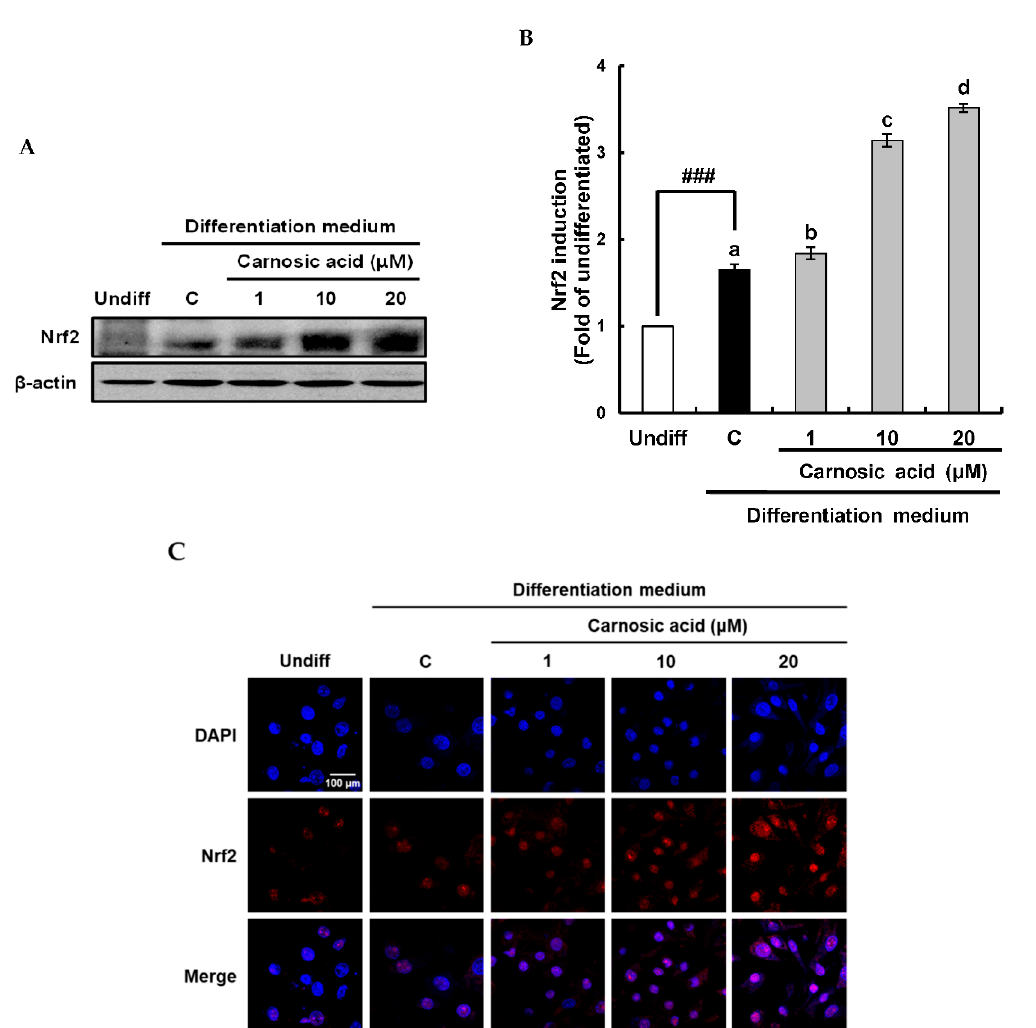
Figure 6. Effects of carnosic acid on translation and nuclear translocation of Nrf2 during MDI-induced differentiation of 3T3-L1 pre-adipocytes to adipocytes for two days. ( A ) Translation of Nrf2 by Western blotting analysis after differentiation for two days. ( B ) Graphic representation of densitometric analysis of Nrf2 blot. ( C ) Immunofluorescence staining of 3T3-L1 pre-adipocyte cells subjected to 1–20 μ M carnosic acid using anti-Nrf2. Data are presented as averages of three independent experiments performed in triplicates and expressed as percentages of the value of the control (means ± standard error mean, n = 3). ### : p < 0.001 vs. Undiff. Different corresponding letters indicate significant differences by Student’s t -test. (Undiff: undifferentiated, which was not treated with the MDI hormone mixture; C: control, which was treated with the MDI hormone mixture; DAPI: 4 ′ ,6-diamidino-2-phenylindole).